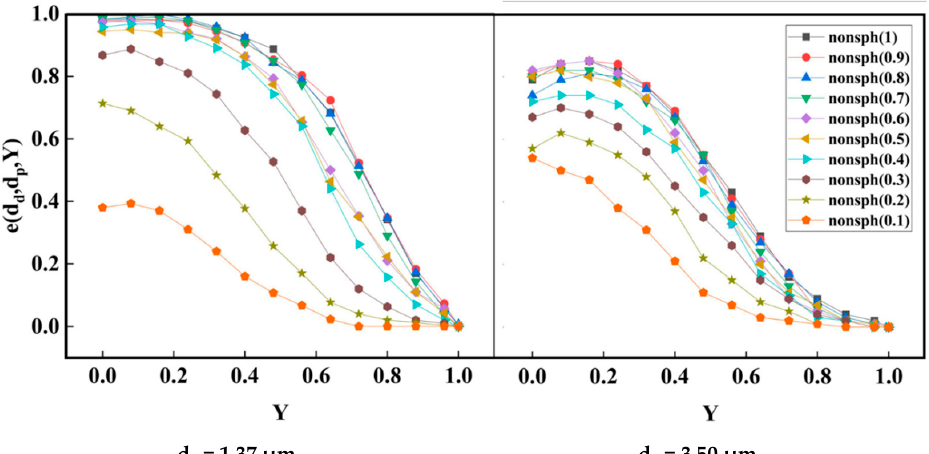
Figure 6. Collision probabilities at different sphericity values.